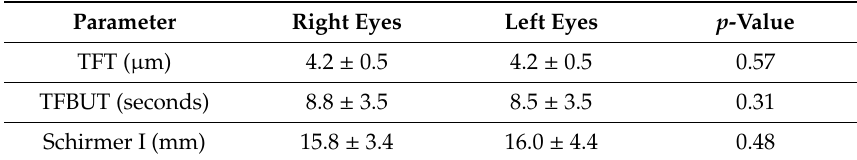
Table 1. Tear film thickness (TFT), break up time (TFBUT), and Schirmer I test in 225 patients with dry eye disease. Data were reported separately for right and left eyes (mean ± SD). Di ff erences between right and left eyes were analyzed by paired